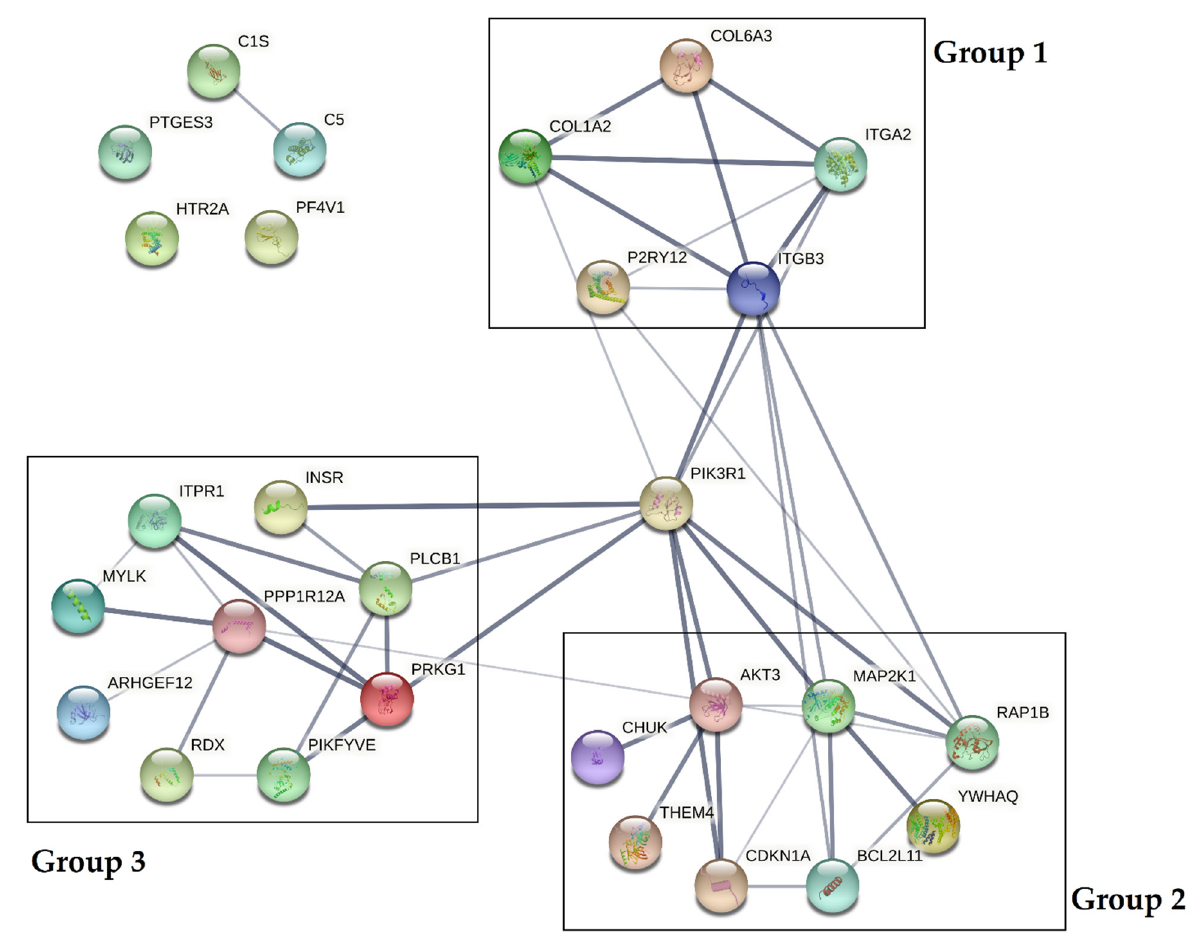
Figure 6. Protein–protein interaction (PPI) analysis of selected proteins present in the platelet proteome. PPIs were determined using the STRING database [18]. The PPI network is presented as lines between nodes, the thickness of which indicates the strength of the interaction.